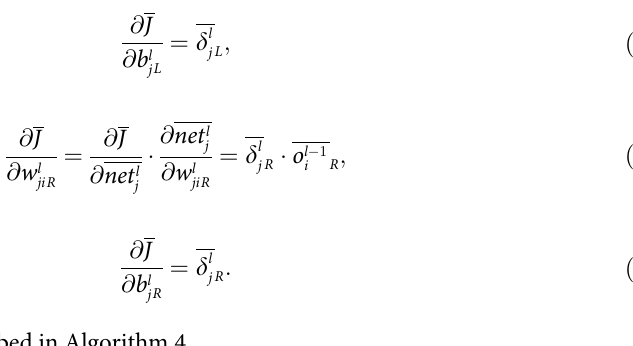
Algorithm 4 The algorithm for fine-tuning the parameters of FDNN using